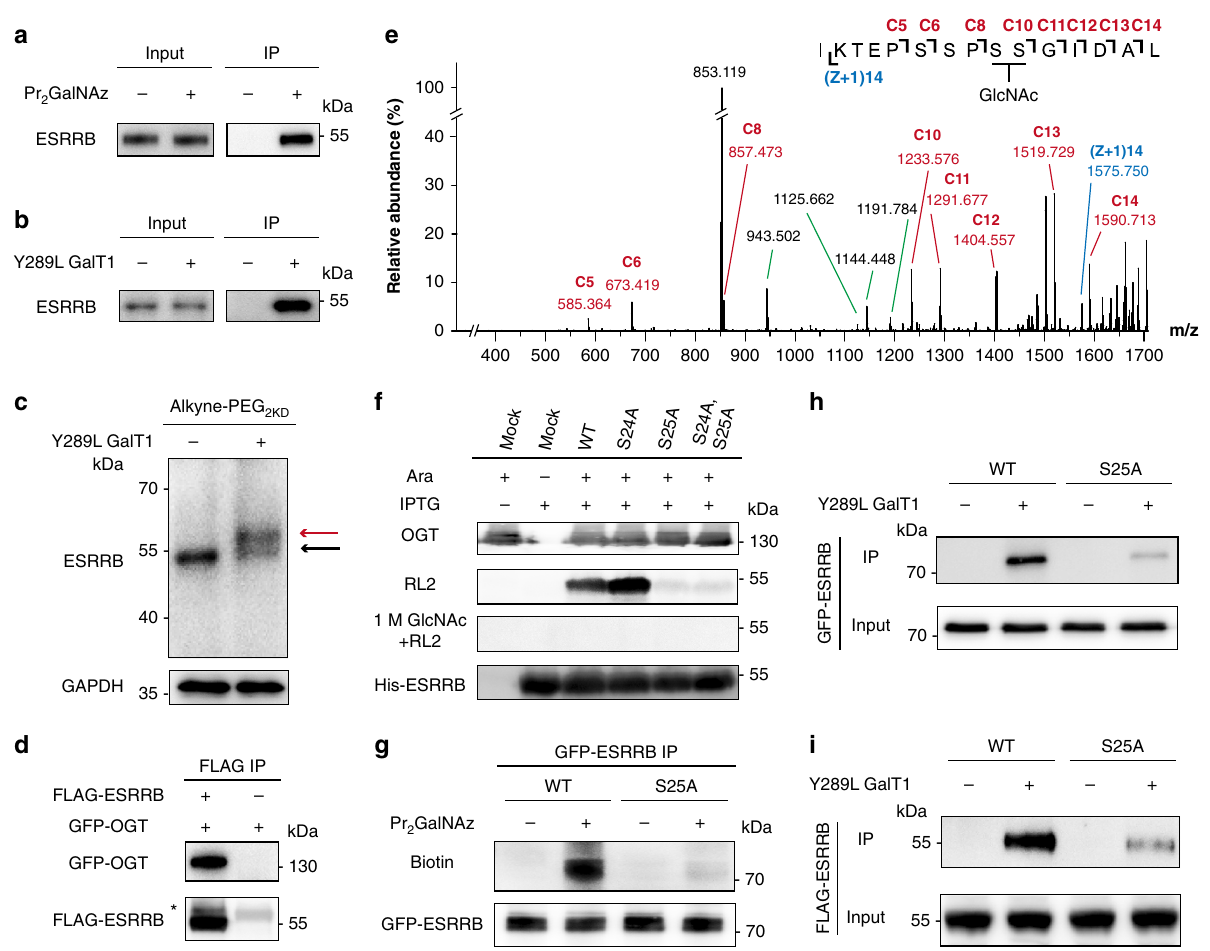
Fig. 3 ESRRB is O-GlcNAcylated at Ser 25. a Immunoblots showing mESC R1 cell lysates incubated with Pr 2 GalNAz, lysed, reacted with alkyne-PEG 4 -biotin, and captured by streptavidin beads. b Immunoblots showing mESC R1 cell lysates incubated with Y289L GalT1 and UDP-GalNAz, reacted with alkyne- PEG 4 -biotin, and captured by streptavidin beads. c Immunoblots showing mESC R1 cell lysates incubated with Y289L GalT1 and UDP-GalNAz, and reacted with Alkyne-PEG 2kD . Anti-GAPDH blot demonstrates comparable loading. d Immunoblots showing HEK293T cells expressing GFP-OGT or co-expressing GFP-OGT and FLAG-ESRRB co-immunoprecipitated with an anti-FLAG antibody. The asterisk indicated IgG heavy chain. e ETD MS/MS spectrum of the ESRRB peptide with an O-GlcNAcylation site. The matched fragment ions are labeled in red and blue. C8 and C10 ions indicate that the O-GlcNAc is located on Ser 24 or Ser 25. f Immunoblots showing E. coli co-expressing OGT (under control of an arabinose-inducible promoter) and His-ESRRB (IPTG- inducible) with single or double mutations. Ara, arabinose. RL2 is an O-GlcNAc-speci fi c antibody. Pre-treatment with 1 M GlcNAc was used to block RL2. g Streptavidin blots showing HEK293T cells expressing EGFP-ESRRB or EGFP-ESRRB S25A incubated with Pr 2 GalNAz for 48 h, lysed, and immunoprecipitated with an anti-GFP antibody. Anti-GFP blot demonstrates comparable loading. h , i Immunoblots showing HEK293T cell